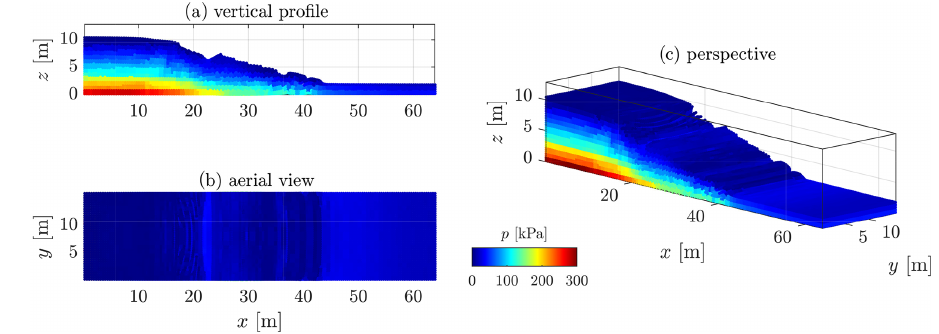
Figure C3. Smoother pressure field when volumetric locking is mitigated with the proposed